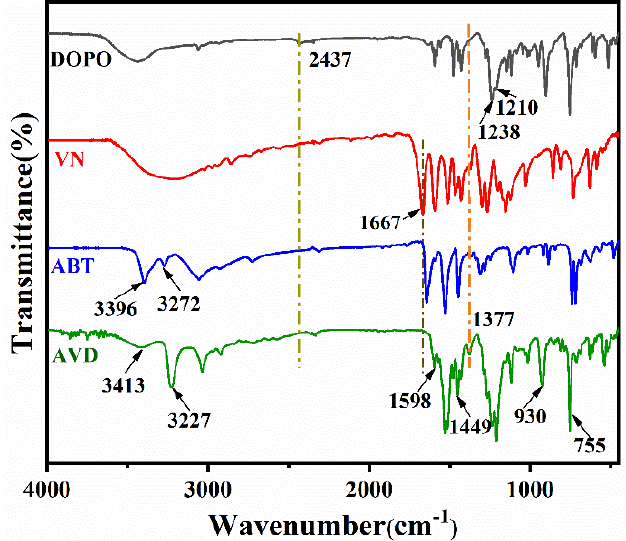
Figure 1. FTIR spectra of DOPO, VN, ABT and